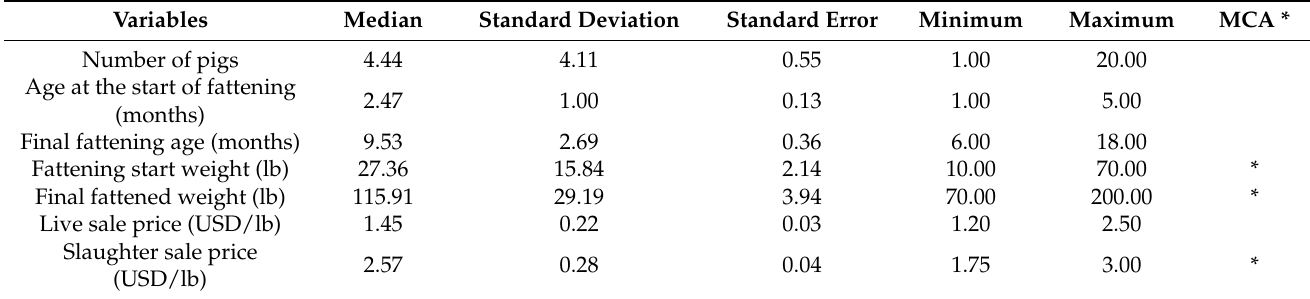
Table 3. Descriptive statistics of pig production levels in El Anegado parish, Jipijapa (N = 55).